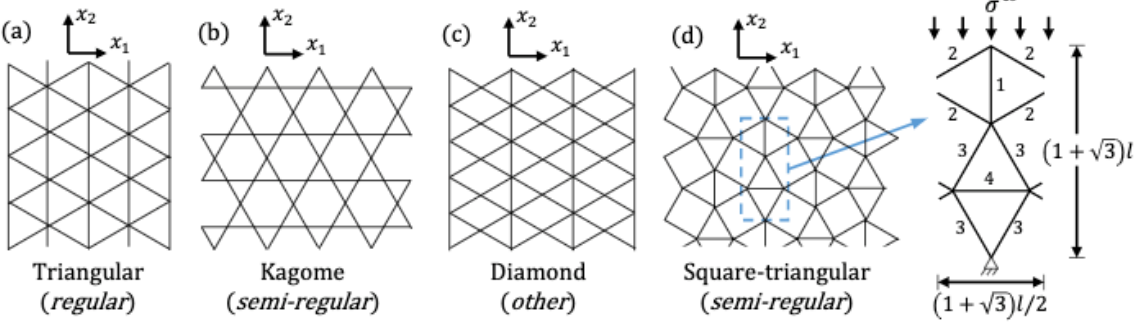
Figure 1. Examples of different lattice topologies: ( a ) triangular; ( b ) Kagome; ( c ) diamond; ( d ) snub square [10] .